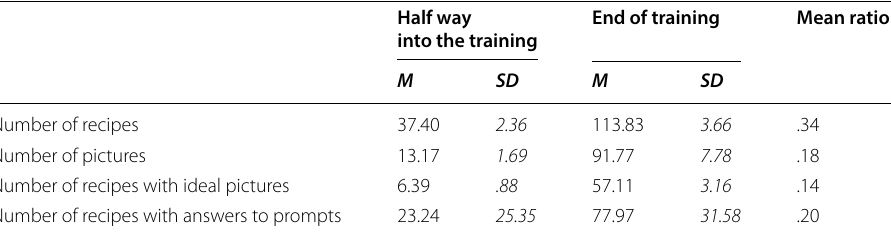
The ratio indicates which proportion of the given feature was already completed halfway through training